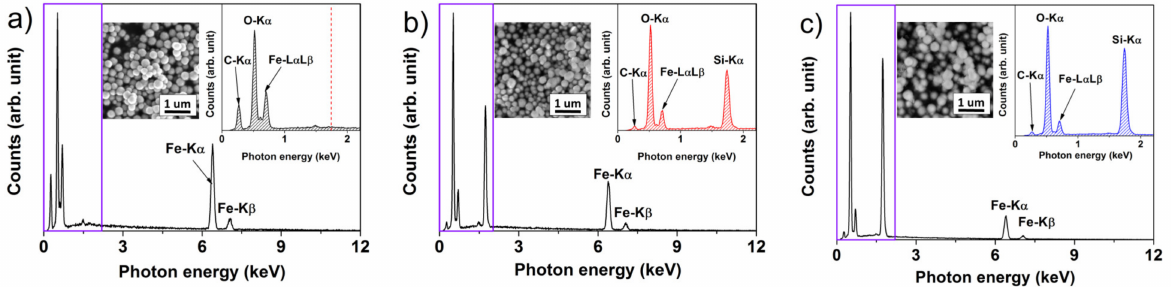
Figure 2. EDX spectra for the ( a ) neat NPs, ( b ) NPs@TEOS and ( c ) NPs@m-TEOS; these spectra were recorded from SEM insets (from an area of 2.5 × 2.5 µ m 2 ); the dashed line in ( a ) represents the position of Si-K α photon energy absent from the